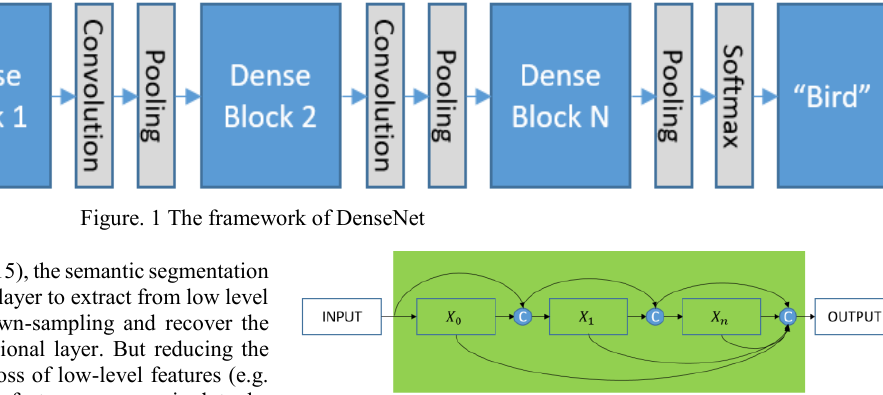
Figure. 2 The framework of Dense Block